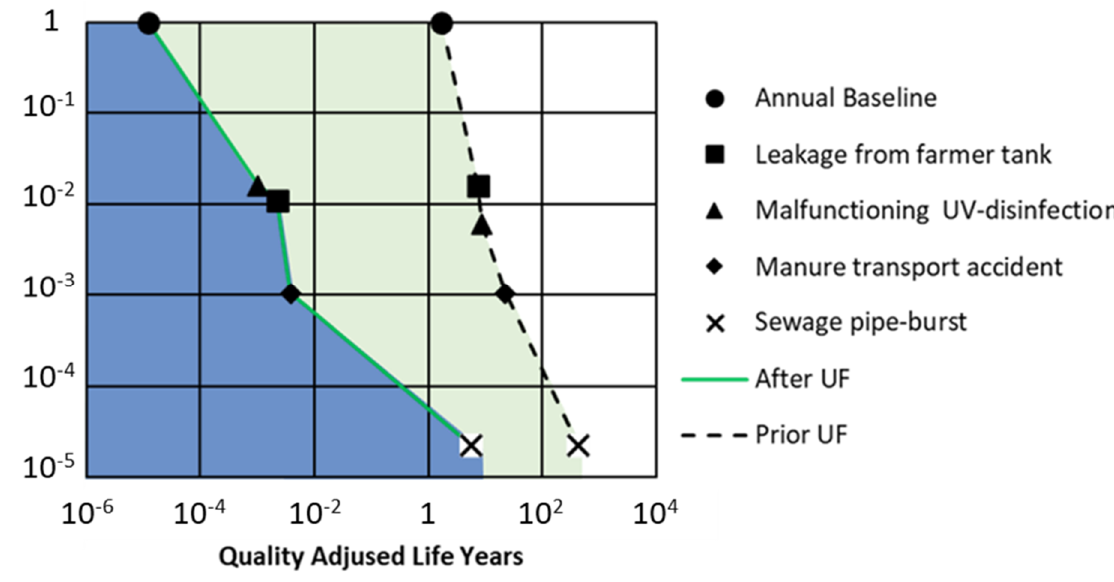
Figure 3. Plot of the total risk of the hazardous events prior and after the UF membrane installation, plotting each event’s cumulative probability of occurrence against its mean consequence. The total risk reduction of the UF membranes is illustrated by the green area, while the total remaining risk is illustrated in